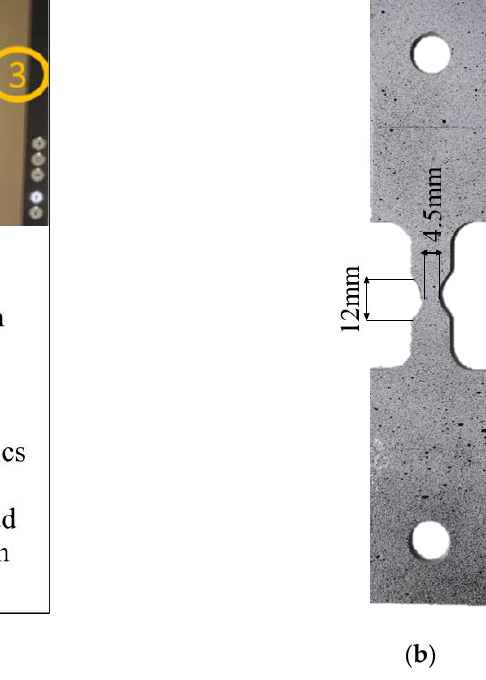
Figure 6. ( a ) Experimental equipment for uniaxial tensile test ; ( b ) speckled notched specimen.